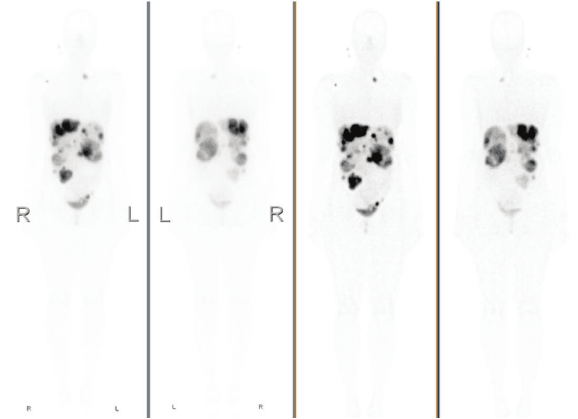
Figure 2: Octreoscan: high uptake in focal areas of the liver, left lower quadrant of the abdomen, and cervicothoracic